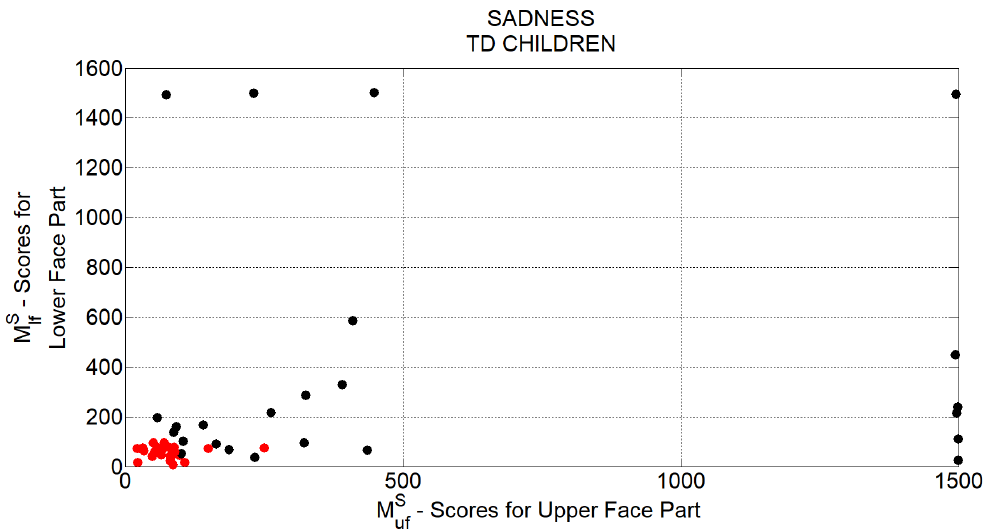
Figure 3. Scores computed for the production of Sad expressions by TD